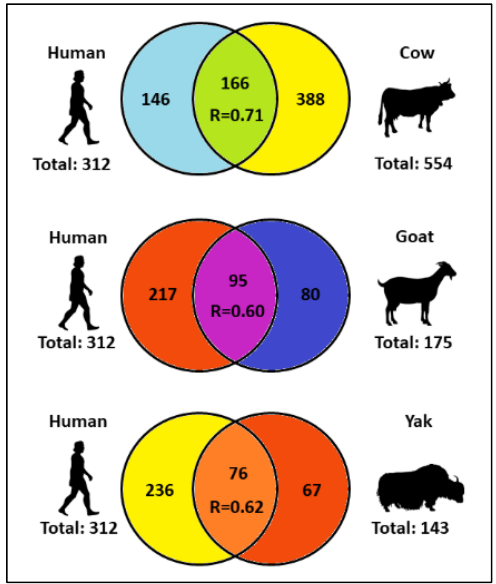
Figure 1. Number of individual and common milk fat globule membrane (MFGM) proteins in human, cow, goat and yak, and Pearson correlation coefficient (R) between the MFGM proteomes of human–cow, human–goat and human–yak. Adapted from Lu et al., 2016 [29]. Although there are quantitative similarities, human and cow MFGM proteomes show qualitative variations. In 2011, Hettinga and collaborators [27] observed slight vari- ations in the number of proteins responsible for various molecular functions in human and cow MFGM proteomes (Table 2). The authors observed that the number of MFGM proteins related to the immune defense was comparable between cows (44) and humans (51). The cow’s MFGM proteome was enriched in antibacterial proteins, named cathelici- dins and mucins, related to innate immunity. Instead, the human MFGM proteome was enriched in four proteins involved in the mucosal immune system: IgA, CD14, lactoferrin and lysozyme [27]. IgA is the major isotype in the mucosal immune system and regulates the balance between commensal microorganisms and pathogens [48]. CD14 is part of the Toll-like receptor (TLR)-4 complex and protects from the invasion of pathogens by acti- vating the innate immune system. Lactoferrin and lysozyme are two antibacterial proteins with a role in the innate immune system. The significantly higher amounts of IgA and CD14 in human MFGM than bovine MFGM (500-fold and 4.7-fold increase, respectively) are explained by the different maturation of the immune system in human newborns and calves. Human and bovine colostral MFGM contain similar amounts of IgA and CD14. However, the concentration of IgA and CD14 decreases in bovine MFGM after the first days of lactation because calves are capable of producing intestinal IgA at 4 days of age, whereas the IgA concentration remains high in human MFGM because the intestine of human newborns is devoid of IgA and CD14 [27].